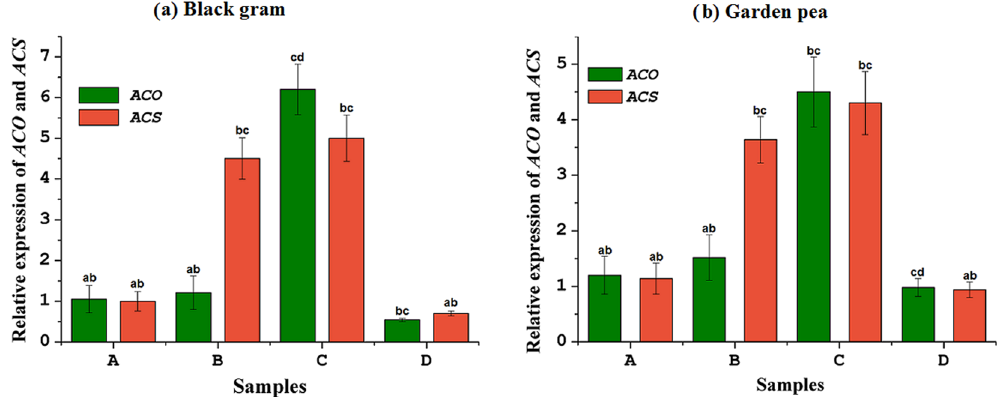
Figure 5. Relative gene expression level of ACO and ACS in leaf tissue of ( a ) black gram and ( b ) garden pea plants in different treatment conditions. Treatments: A- uninoculated watered plants as positive control, B-consortium ( Ochrobactrum pseudogrignonense RJ12 + Bacillus subtilis RJ46 + Pseudomonas sp.RJ15) inoculated plants with drought stress induction, C- uninoculated plants under drought stress as negative control, D-consortium ( Ochrobactrum pseudogrignonense RJ12 + Bacillus subtilis RJ46 + Pseudomonas sp.RJ15) inoculated with sufficient water supply. Two-way ANOVA was performed considering water supply and bacteria inoculation as two independent variables followed by Tukey’s post-test for each treatment. Different symbols on bars indicates a significant difference at p = 0.05 in gene expression under different treatment condition.